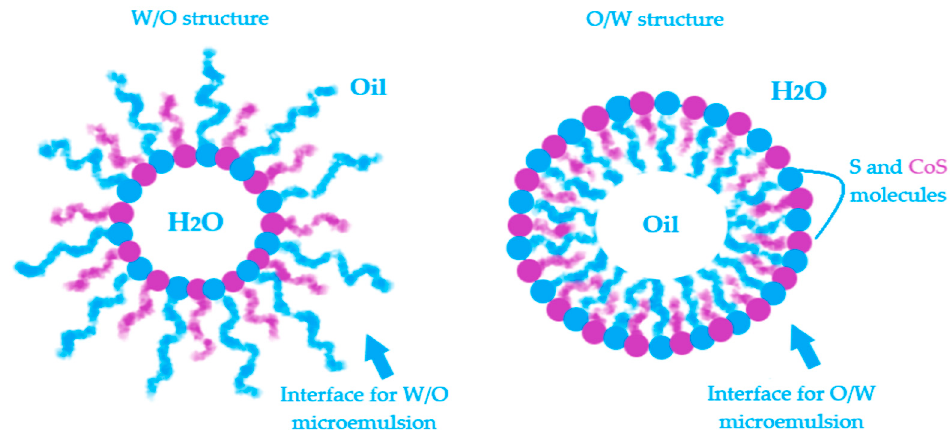
Figure 5. Exemplification of model structure with particles as a part of water in oil microemulsions and oil in water microemulsions and the specific orientation of surfactant and cosurfactant at the